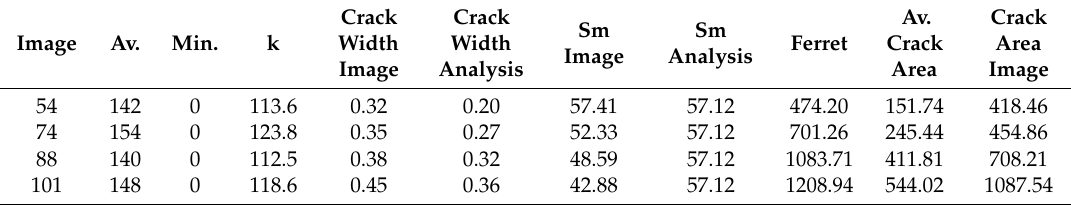
Table 2. Measured and calculated results for Specimen 2.